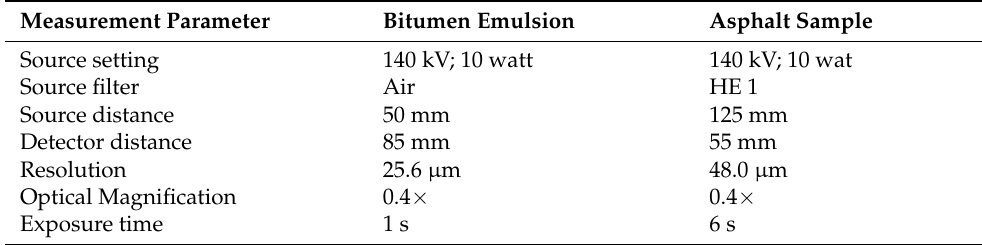
Table 2. Measurement parameters of the µ-CT acquisitions.